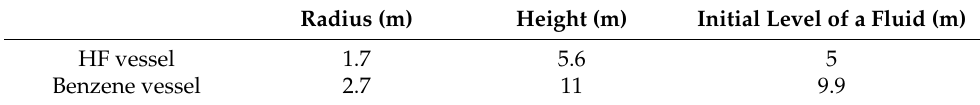
Table 1. Vessel specifications of the hydrogen fluoride(HF) and benzene tanks.